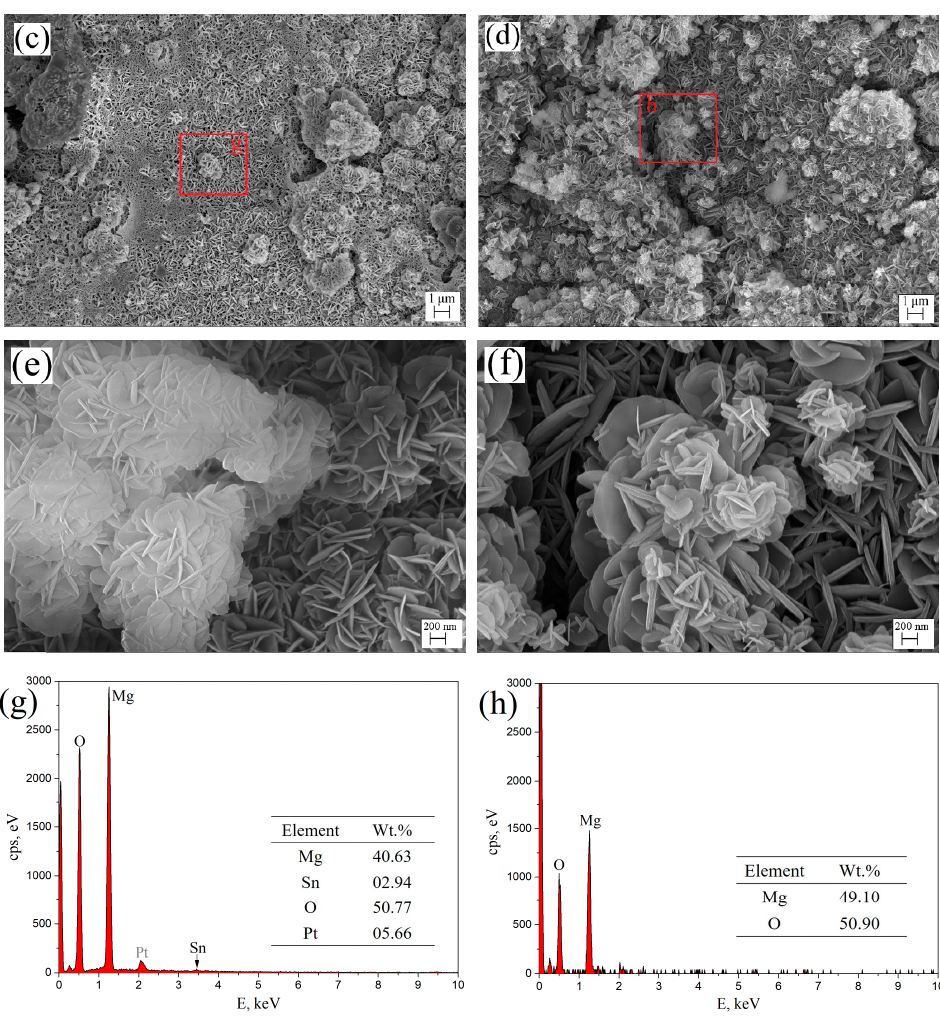
Figure 8. Surface morphologies ( a – f ) and EDS spectra ( g , h ) of aged Mg-3Sn and Mg-3Sn-1Ca alloys for 7 h at 513 k after immersion in 3.5 wt.% NaCl solution for 12h: ( a , c , e ) Mg-3Sn; ( b , d , f ) Mg-3Sn-1Ca; ( g ) Area g in ( c ); ( h ) Area h in ( d ).